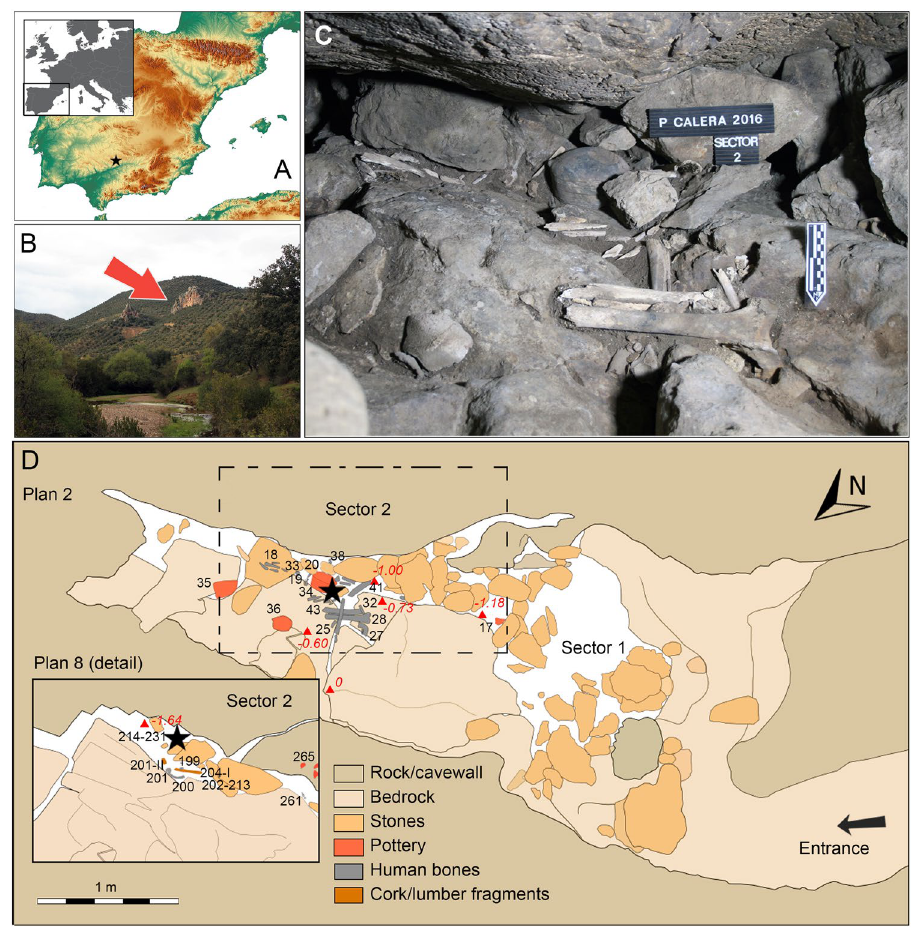
Figure 1. ( A ) Location of the Peñacalera site in the south of the Iberian Peninsula. ( B ) Guadalbarbo Creek Valley, with limestone outcrops behind, where the cavity is located, marked with a red arrow. ( C ) Image of the burial context of Peñacalera, sector 2, where Textile 1 was found. ( D ) Plan 2 of the burial context with detailed Plan 8; red numbers indicate relative depths, black numbers are inventory numbers of the finds; the black star in Plan 2 indicates the approximate location of Textile 5’s find spot; the black star in Plan 8 indicates the find spot of Textile 1. Maps generated by Inkscape (https:// inksc ape.